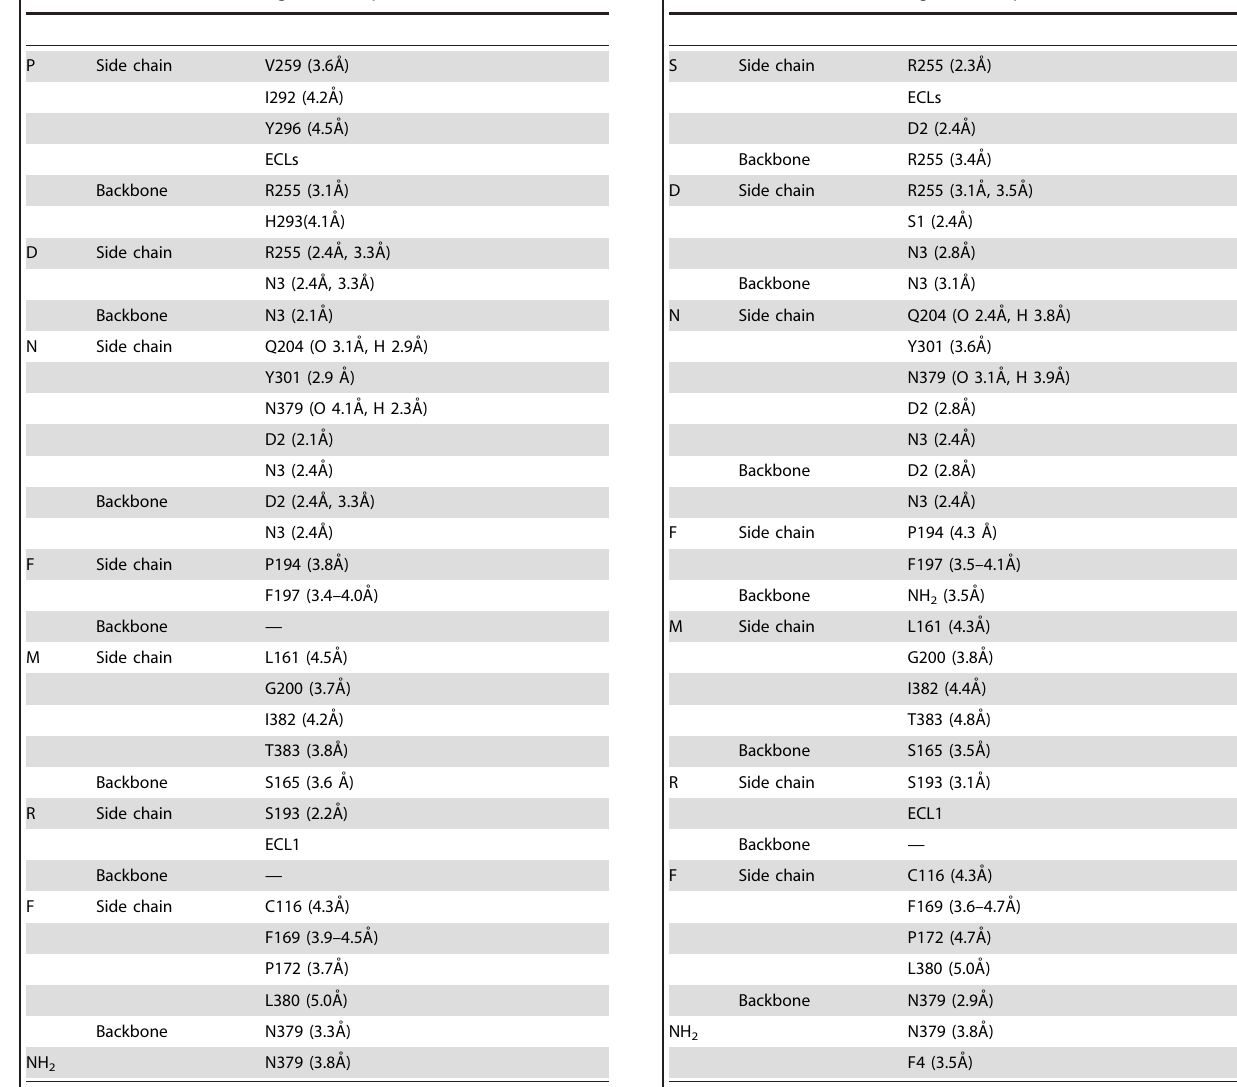
Table 7. PDNFMRF-NH 2 ligand-receptor contact sites a . Table 8. SDNFMRF-NH 2 ligand-receptor contact sites a